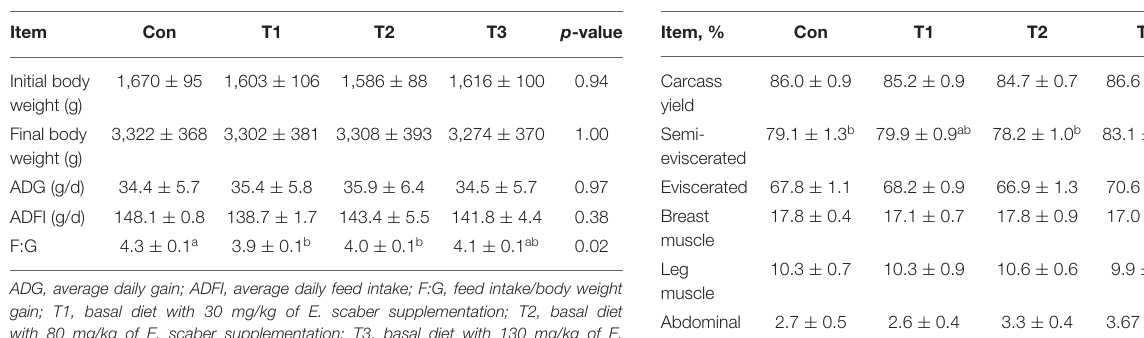
TABLE 3 | Effects of dietary supplementation with Elephantopus scaber on carcass parameters of